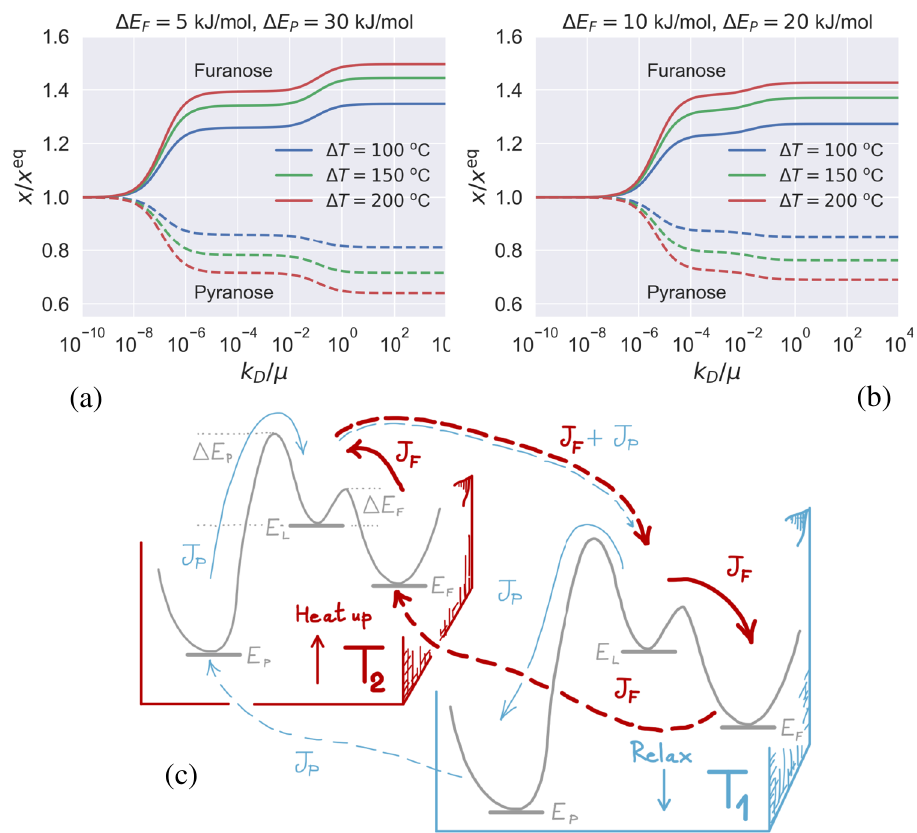
Fig. 4 Increasing the transport rate for Δ E F < Δ E P leads to non-equilibrium kinetic selection of furanose beyond thermodynamic equilibrium, as the energy harvested at the hot end is dissipated at the cold end causing population inversion. a , b The steady-state molar fractions of furanose (solid lines) and pyranose (dashed lines) computed for the two-box model illustrated in Fig. 3 are plotted against the transport rate for different choices of the temperature gradient Δ T = T 2 − T 1 and two choices of energy barriers (see Supplementary Note 4 for the mathematical details). Populations are Þ þ x eq ð T ÞÞ = 2. c Illustration of the steady system of currents ( J J normalised to the equilibrium values, i.e. x eq (cid:5) ð x eq F ð T F , P ) that sustain the non-equilibrium F 1 2 stabilisation of furanose for Δ E P > Δ E F (see also Supplementary Note 6). Dashed arrows denote mass transport, solid lines stand for chemical transformations. The current J P is much smaller than J F in the fast-transport limit, Da ⪅ 1. Parameters used in the two-box model are: T 1 = 60 °C, η F = 29.34, η P = 1.94, E L = 19 kJ/mol, E F = 13.6 kJ/mol, E P = 3.1 kJ/mol, corresponding to the average values for the two furanose and pyranose enantiomers measured from our equilibrium NMR experiments (see Table